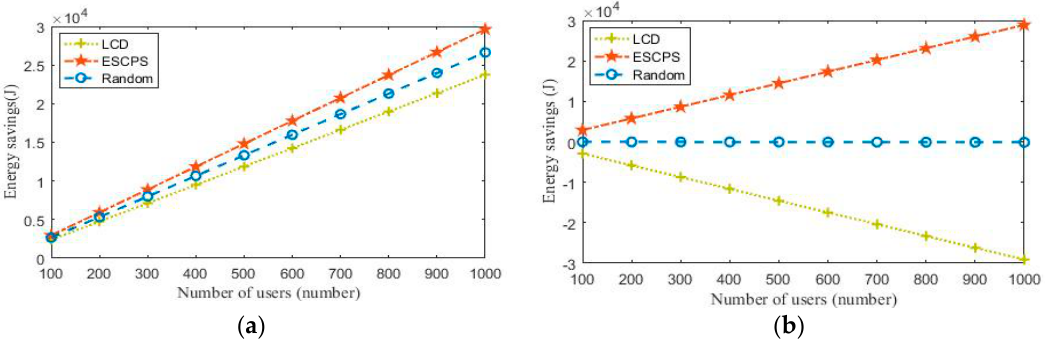
Figure 3. ( a ) The effect of the number of users on energy savings ( P c = 0.1); ( b ) the effect of the number of users on energy saving ( P c = 1).